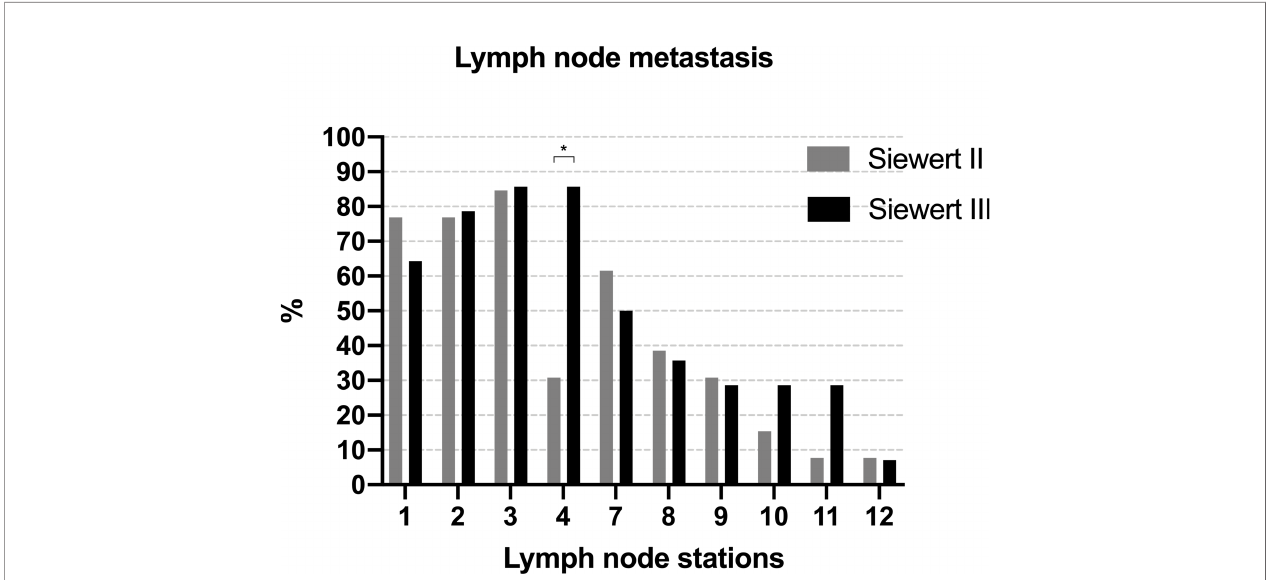
FIGURE 6 | The metastatic rate of lymph node in PLN-positive Siewert type II/III cancers at each station (* p = 0.004).